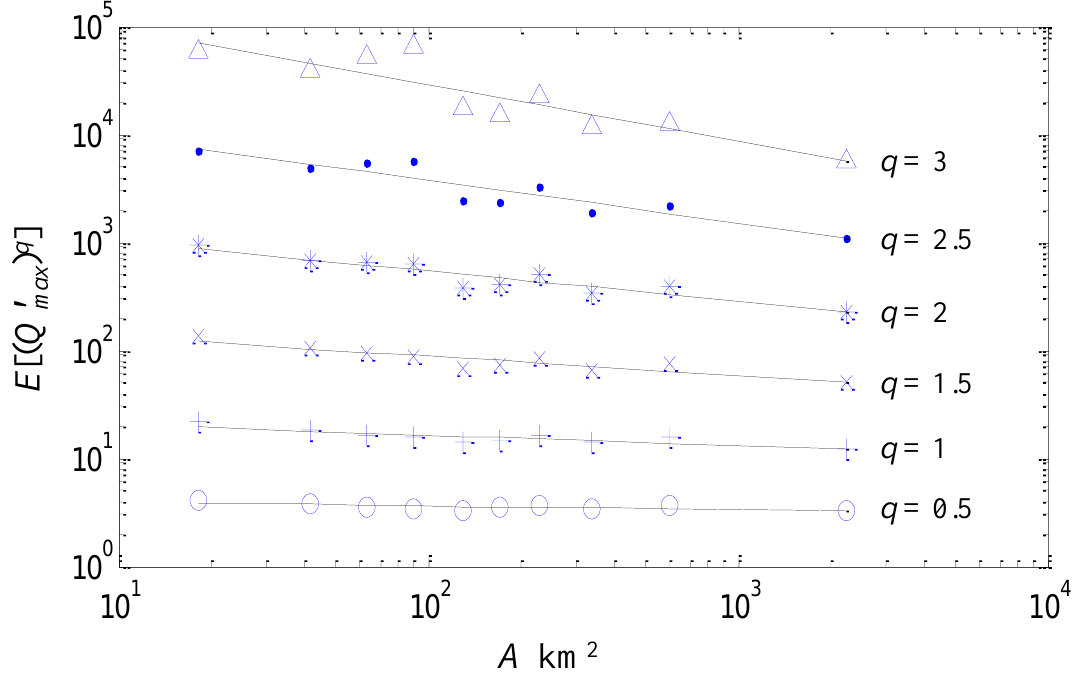
(cid:104) (cid:105) ( Q (cid:48) ) q of standardized annual discharge maxima max